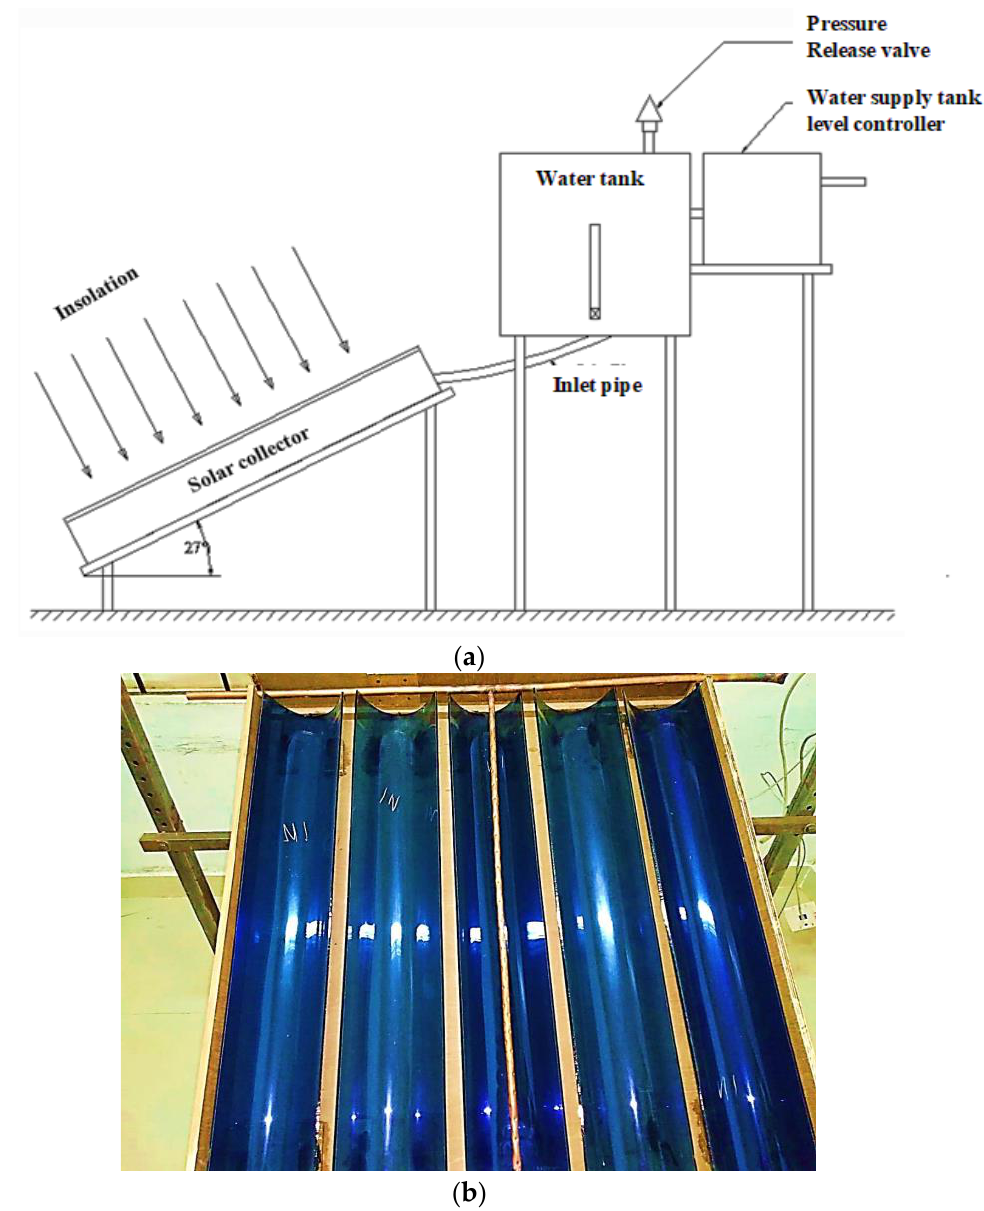
Figure 1. ( a ) The layout of a solar water heating system. ( b ) Parabolic Trough Solar Collector (PTSC). A solar heater can save as much as 70% of the water heating costs. Solar water heaters and solar space heating have many commonalities. PTSCs are often mounted on the roof’s south side to use the sun’s energy. Usually, the outer dimples tube had a solar radiation intensity of 846 W/m 2 and supplied a constant heat flow with turbulent flows of 500 W/m 2 . Water heated by the sun is stored in a tank in the same way as a standard tank-style water heater, and each faucet receives hot water via the same distribution system. The PTSC is often oriented toward the sun and has a constant water supply. The specifications of the experimental setup are given in Table 2.